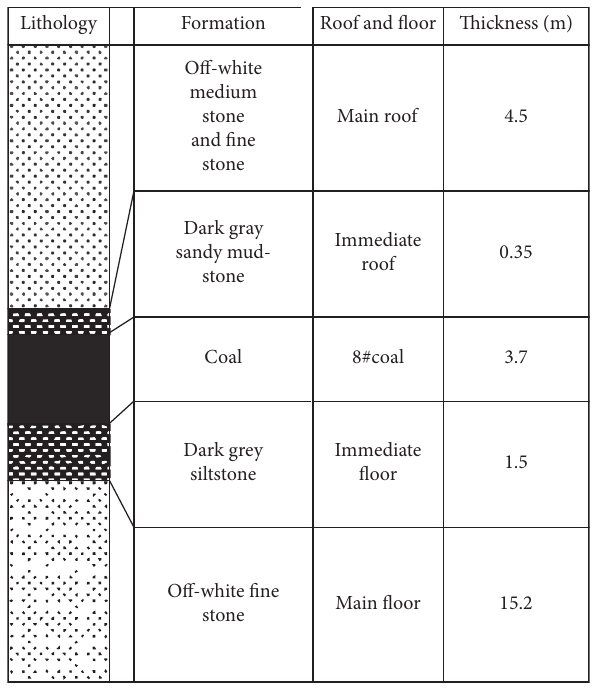
Figure 2: Roof and floor condition of 8103 working